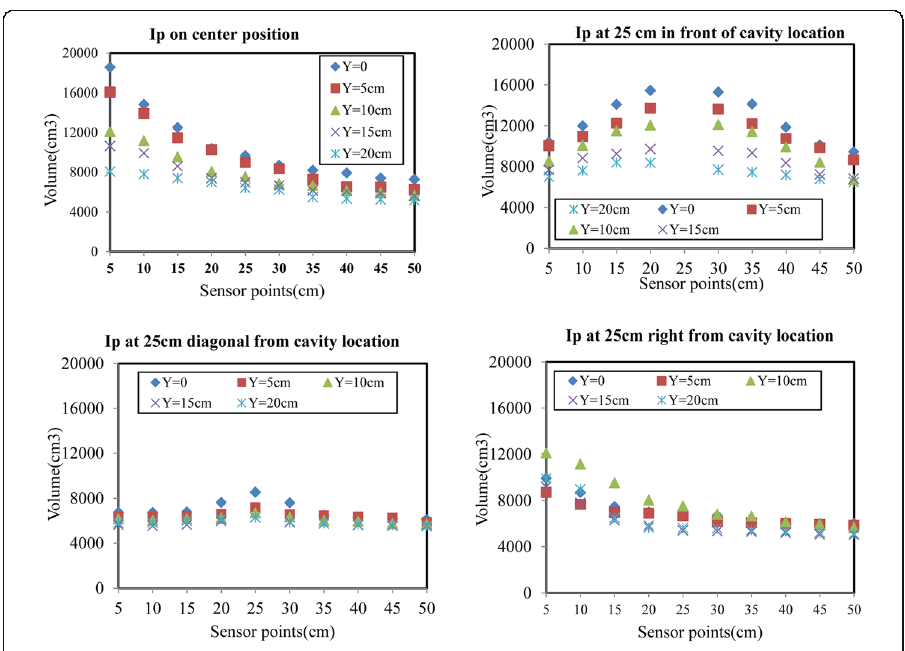
Fig. 21 Volume analysis for cavity size 5 × 5 × 5